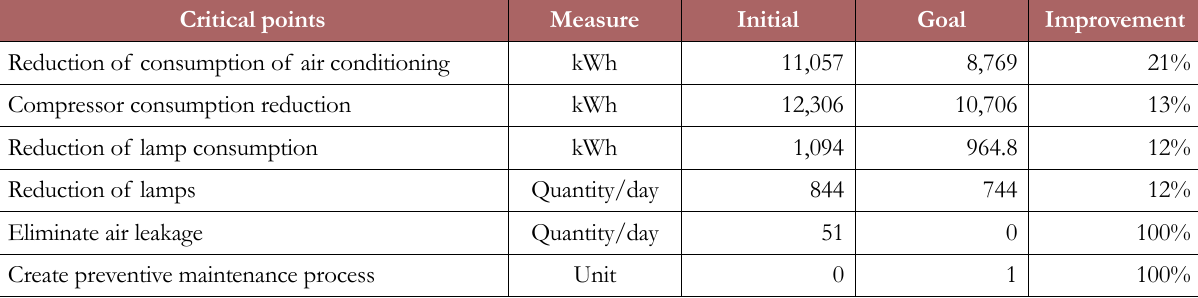
Table 4. Plan to reduce the energy consumption of